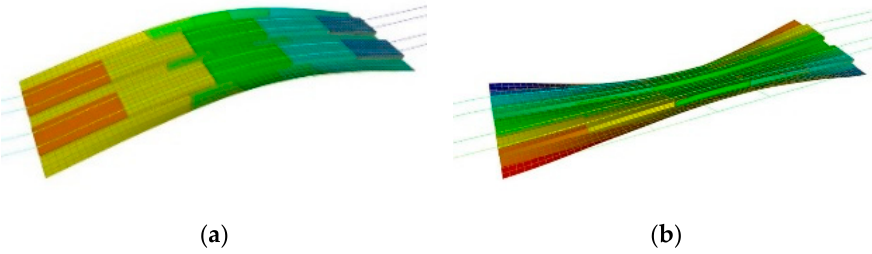
Figure 9. Vibration modes for span length of 35 m: ( a ) first mode (flexure); ( b ) second mode (torsion). Table 5. Analytically obtained natural frequencies and critical speeds per train type.